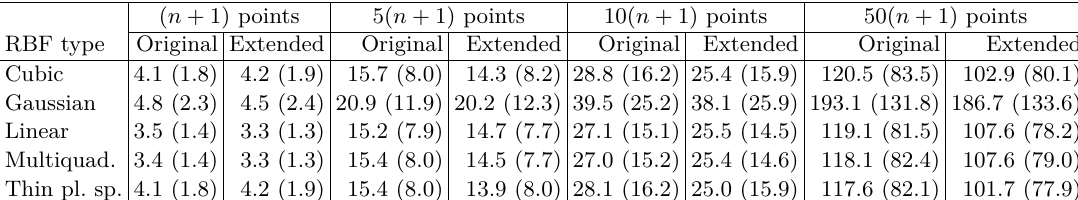
Table 3 Average (standard deviation) of the absolute difference between the true rank and the inferred rank of random points, in the original and the extended